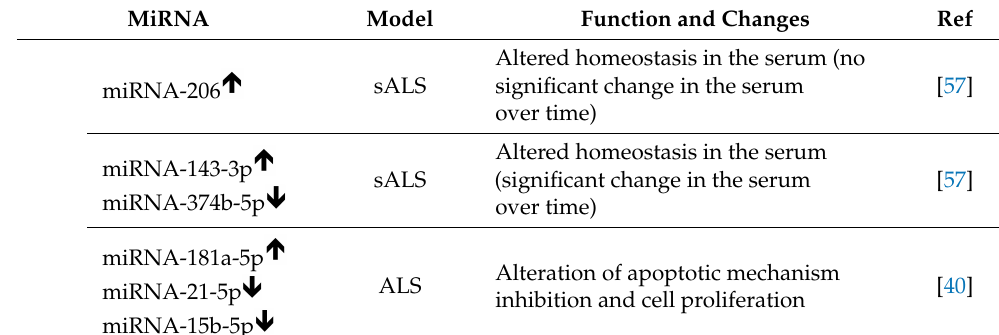
Table 1. Cont. MiRNA Model Function and